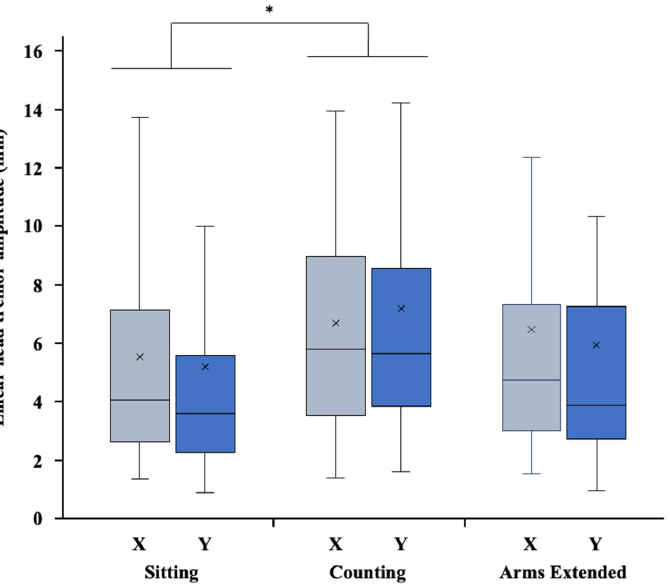
Figure 3. Box plots of the linear head tremor amplitude obtained from video data along the x (X, horizontal) and y (Y, vertical) axes in the sitting, arms extended, and counting conditions. In each box, the center line and the cross respectively represent the median and the mean value, the top and bottom of the box correspond to the 25th and 75th percentiles, and the whiskers represent the 10th and 90th percentiles. Note: * indicates a significant difference between conditions ( p < 0.05).